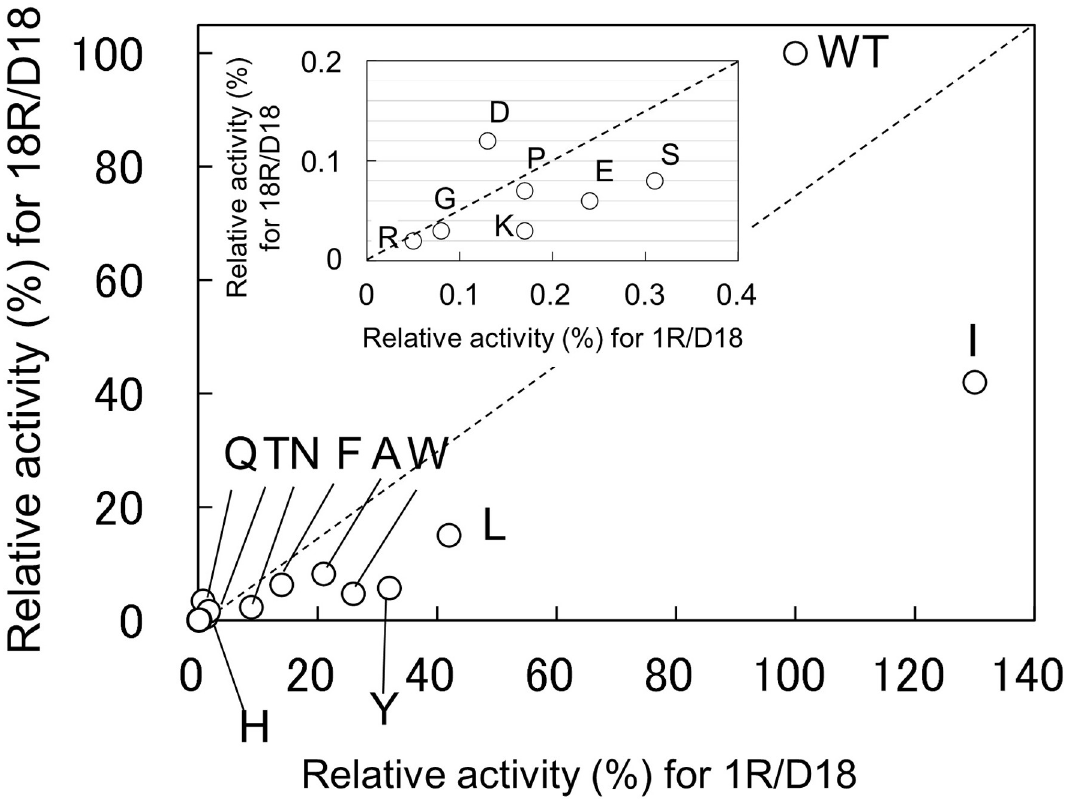
Fig 4. Comparison of the R1/D18-hydrolytic activity with the R18/D18-hydrolytic activity of Val143 variants. The reaction was carried out in 50 mM Tris-HCl buffer (pH 8.0), 5 mM MgCl 2 , 60 mM KCl, 5.6 nM R1/D18 or 5.6 nM R18/D18 at 25˚C. Relative activities, which were activities relative to WT, in the hydrolysis of R1/D18 and R18/D18 were